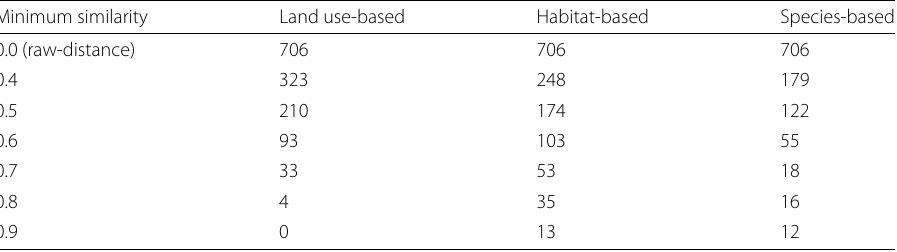
Table 1 Number of edges in similarity-based graphs of Natura 2000 sites in Sardinia, using Jaccard